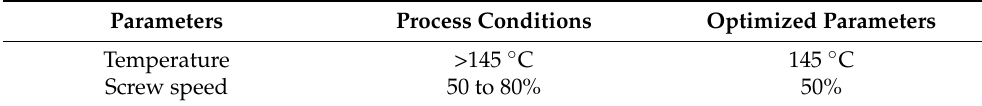
Table 2. Mixture processability parameters starch-based materials in the RMX.